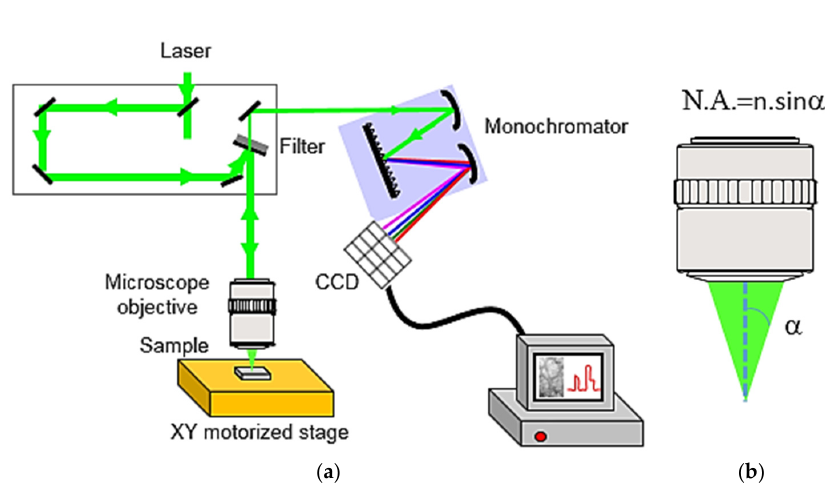
Figure 2. Experimental set ‐ up with a backscattering geometry: ( a ) Details of the system; ( b ) Definition of the numerical aperture (N.A.), with n the index of refraction of the medium in which the lens is working and α the maximal half ‐ angle of the cone of light that can enter or exit the lens.